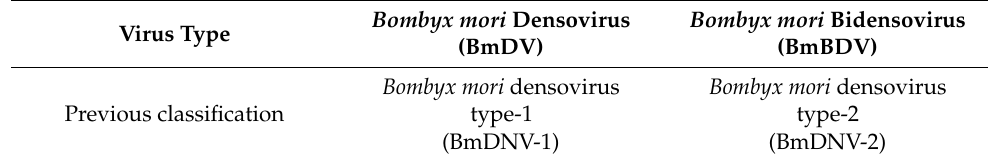
Table 1. Salient features of Bombyx mori densovirus (BmDV) and B. mori bidensovirus